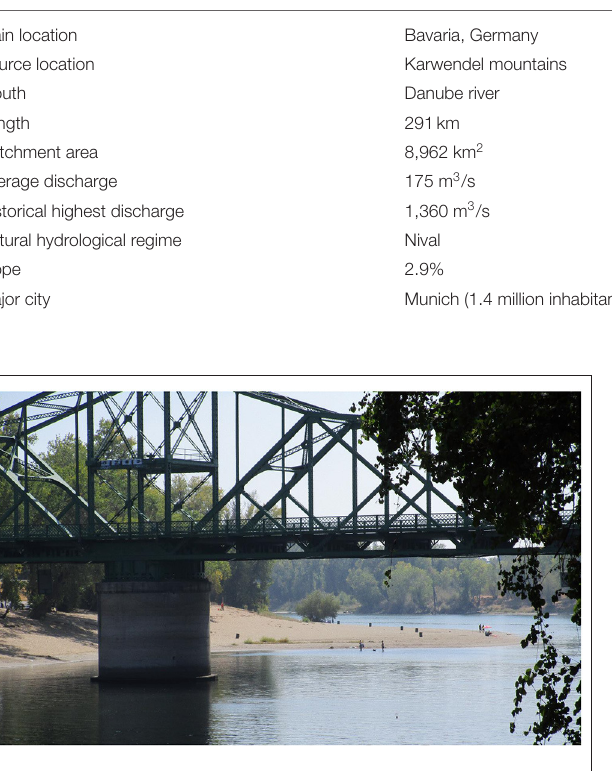
FIGURE 4 | Public uses of the Lower American River (August 2021, credit: Aude Zingraff-Hamed).